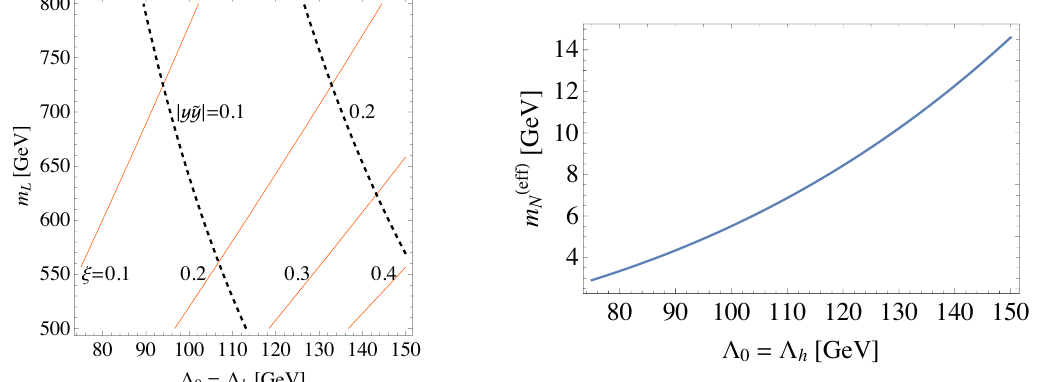
Figure 7 . The parameters in the model of strong sector. Left: the black dashed lines indicate j y ~ y j = 0 : 1 ; 0 : 2 and the red solid lines indicate (cid:24) = 0 : 1 ; 0 : 2 ; 0 : 3 ; 0 : 4. Right: the lightest fermion mass in the strong